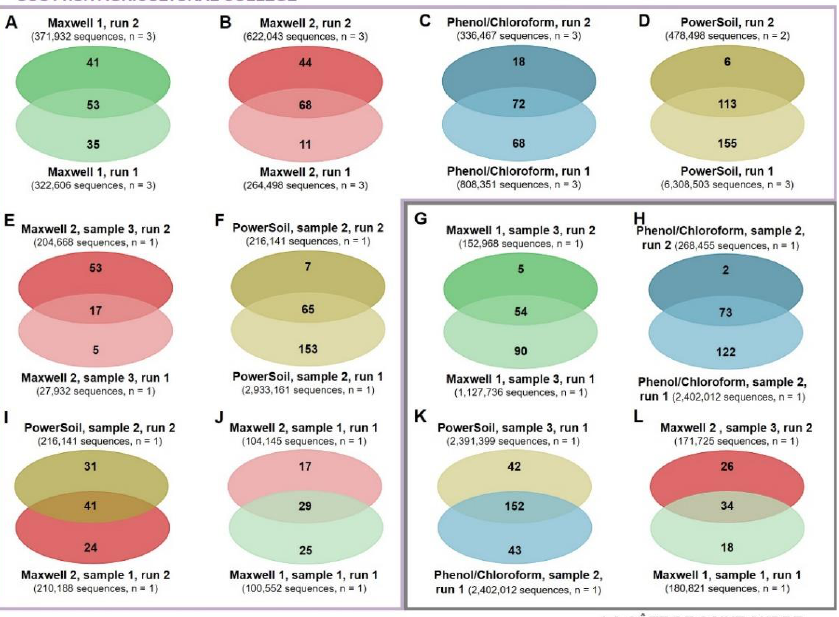
Figure 6. Venn Diagrams representing shared and unique ARGs from triplicates extracted using the same method sequenced in two different runs ( A – D ): individual samples sequenced at different depths ( E – H ) and samples extracted using different methods and sequenced at similar depths ( I – L ). Maxwell 1 and 2: modifications of the prototype Maxwell RSC Fecal Microbiome DNA Kit (Promega). PowerSoil: DNeasy PowerSoil Kit